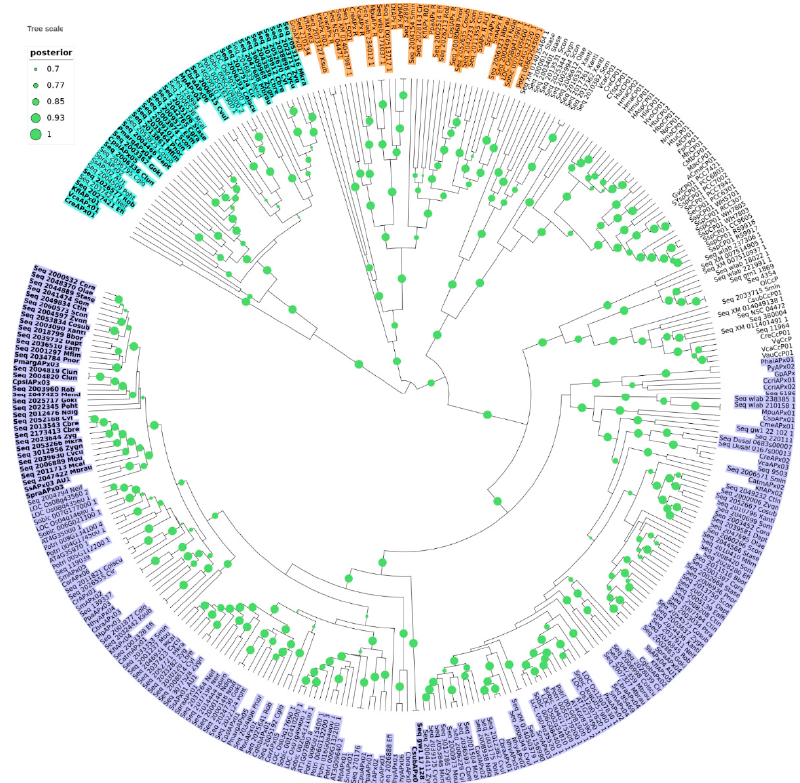
Figure 1. The phylogenetic relationship between APX, APX-R, APX-L, CCP, and KATG (CP) was reconstructed using the Bayesian method. A total of 348 protein sequences were included in the analysis, and ambiguous positions were removed from the alignment. APX, APX-R, and APX-L families are separated in three well-supported clusters and colored in purple (APX), orange (APX-R), and cyan (APX-L). Protein sequences that display hybrid features are indicated in bold letters. The posterior probabilities are discriminated according to the figure legend; only values above 0.7 are indicated.